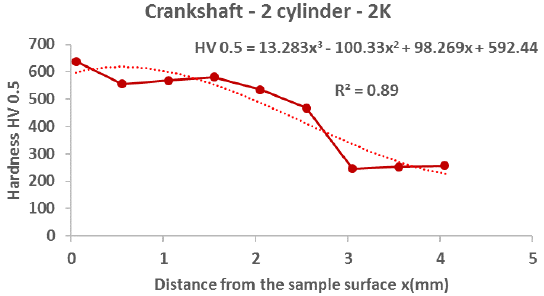
Figure 20. Regression analysis for a 3rd − order polynomial for crankshaft values on 2nd cylinder.